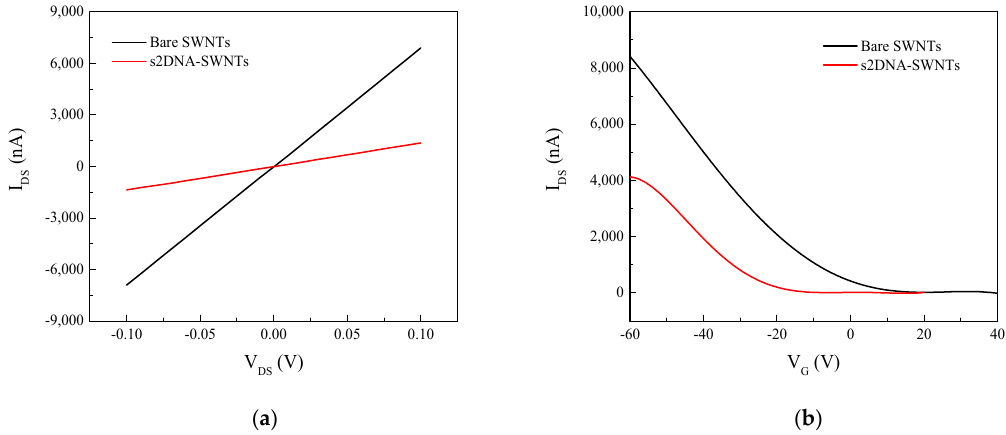
Figure 5. ( a ) Drain-source Current–voltage ( I DS –V DS ) characteristics of SWNTs before and after functionalization with s2DNA at base voltage ( V G ) = 0 V. ( b ) Transfer characteristic curve for bare and s2DNA-coated SWNT device at V DS = 0.1 V.